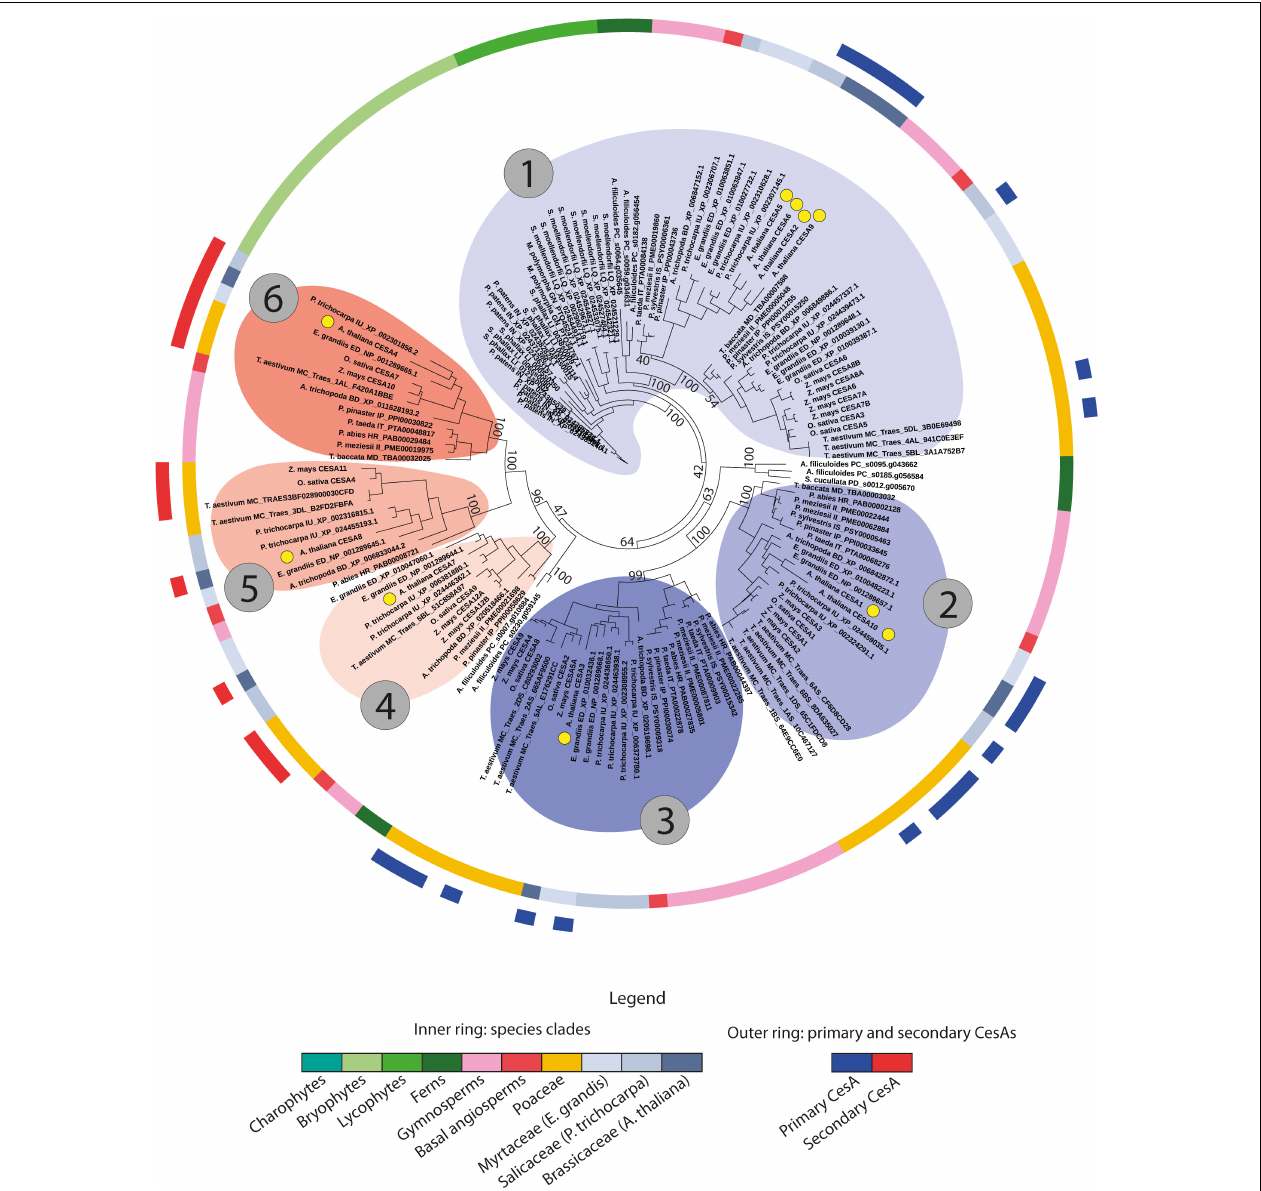
FIGURE 5 | Phylogenetic tree of a subset of 151 CesA genes including sequences from model plant species, from species where primary and secondary cell wall CesA genes have been experimentally validated ( Supplementary Table 3 ), along with all gymnosperm, fern, lycophyte, bryophyte, and charophyte CesA sequences. The tree shows that early-diverging plant sequences are only occurring closest to primary cell wall CesA branches (especially clade 1). Moreover, it highlights the subdivision of the CesA sequences into the six main phylogenetic groups corresponding to known primary and secondary cell wall CesA isoforms from different species. The inner ring indicates taxonomy, while the outer ring highlights the position of experimentally validated primary and secondary cell wall CesA genes (see legend at the bottom of the figure). Coloured clades around branches indicate the six main CesA clades, numbered in the same way as in Figure 3 . Blue clades indicate primary cell wall CesA genes, while red clades indicate secondary cell wall CesA sequences. Bootstraps supporting clade subdivisions are reported. Yellow dots indicate the position of the 10 A. thaliana CesA genes.